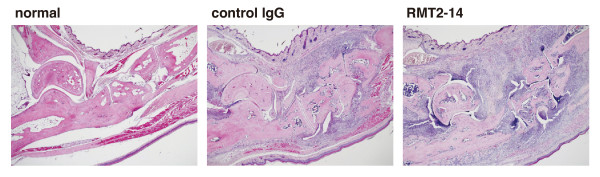
Effect of anti-TIM-2 mAbs on histopathological arthritis. Hind paws from normal mice and control IgG- or RMT2-14-treated collagen-induced arthritis (CIA) mice at day 45 were stained with H&E. Original magnification, × 4. Representatives in each group of 10 mice are shown.